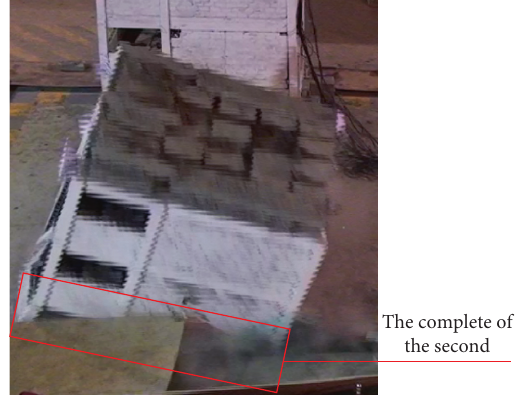
Figure 40: Second-floor collapse of the test (right).